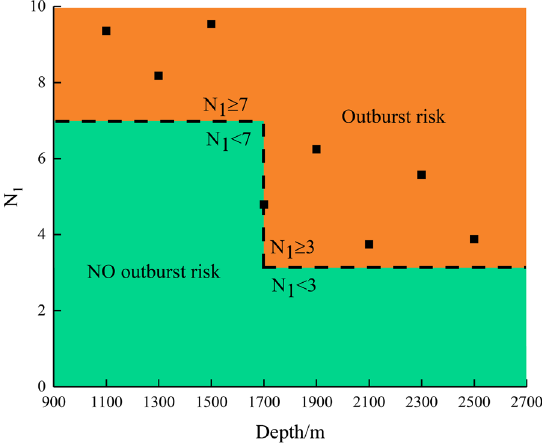
Fig. 10 Relationship between risk index N